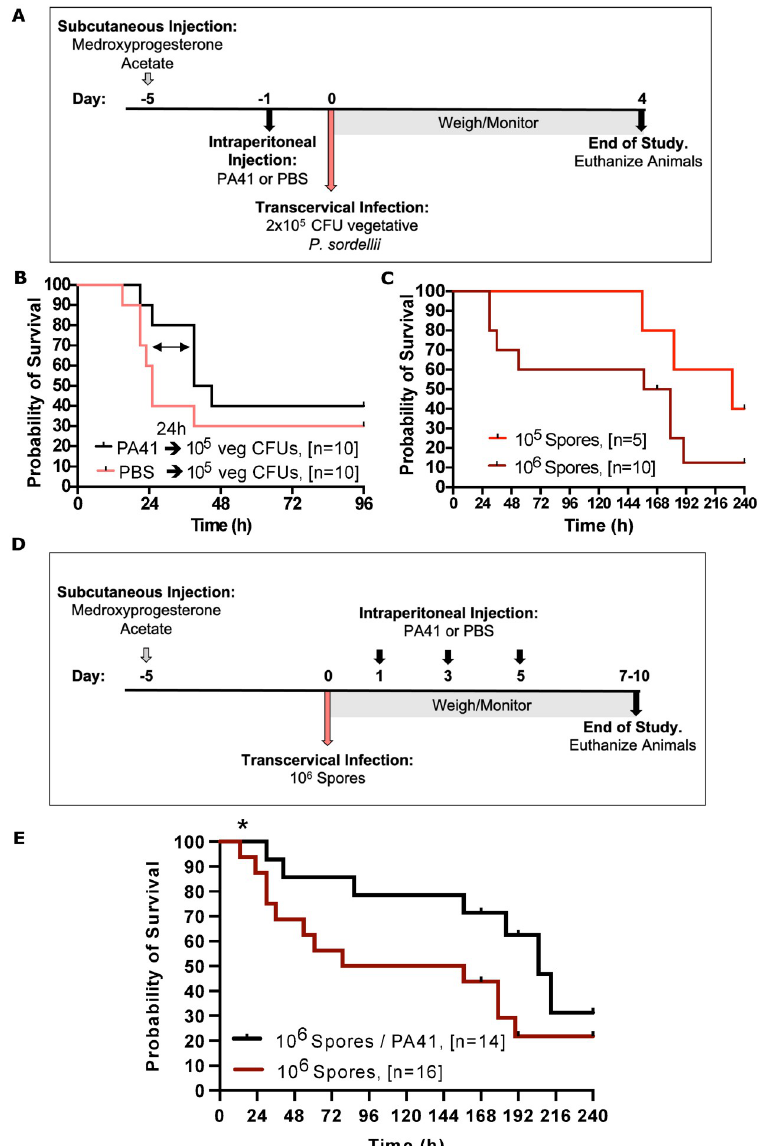
Fig 6. Prophylactic and therapeutic administration of PA41 following transcervical P . sordellii vegetative bacterial or spore infection, respectively. (A) Timeline showing subcutaneous administration of medroxyprogesterone acetate on Day -5 to induce diestrus, intraperitoneal injection of 7.5 mg/kg PA41 or PBS on Day -1, and transcervical infection of 10 6 vegetative P . sordellii bacteria on Day 0. Animals were weighed/monitored for four days. (B) Survival curve of diestrus animals prophylactically treated with PA41 or PBS and TC inoculated with 2x10 5 CFUs vegetative bacteria. (C) Survival curve following transcervical inoculation of 10 5 and 10 6 spores in mice in diestrus. (D) Timeline showing subcutaneous administration of medroxyprogesterone acetate on Day -5 to induce diestrus, transcervical infection of 10 6 spores on Day 0 and intraperitoneal injection of 7.5 mg/kg of PA41 or PBS one-, three-, and five-days post-infection. Animals were weighed/monitored for 7–10 days. (E) Survival curve of diestrus animals treated with PA41 or PBS following TC inoculation of 10 6 spores. Gehan-Breslow-Wilcoxon test was used with statistical significance set at a p value of < 0.05. Gehan-Breslow-Wilcoxon p = 0 . 0424 , Log-rank p = 0 . 0624 .